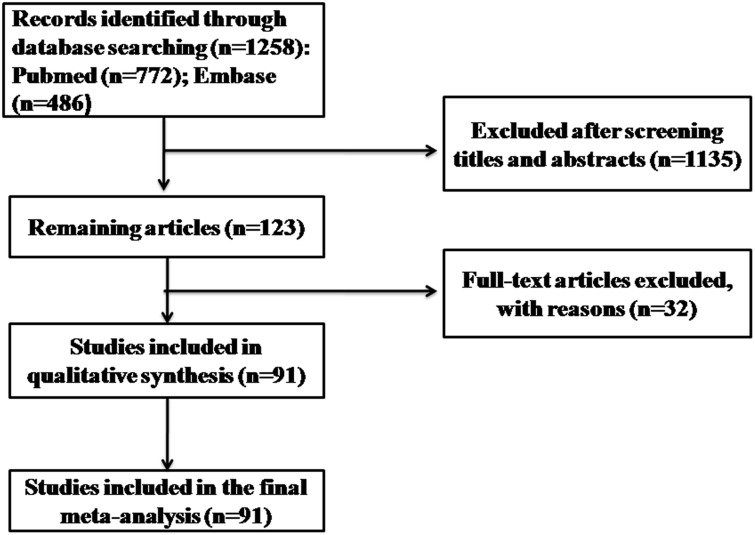
Flowchart of study selection.